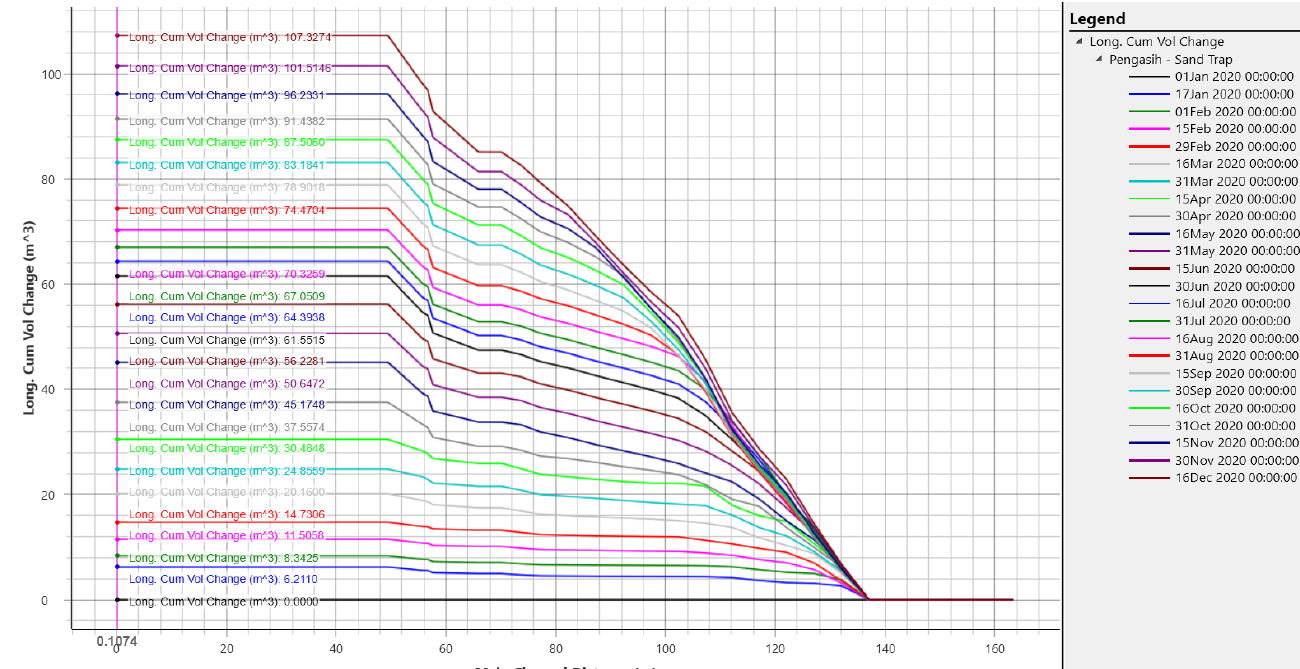
Figure 16. The bi-weekly cumulative volume change along the sand trap due to the incoming sediment during the operational period. The values are presented every two weeks according to the irrigation requirement discharge settings in the Pengasih irrigation scheme.